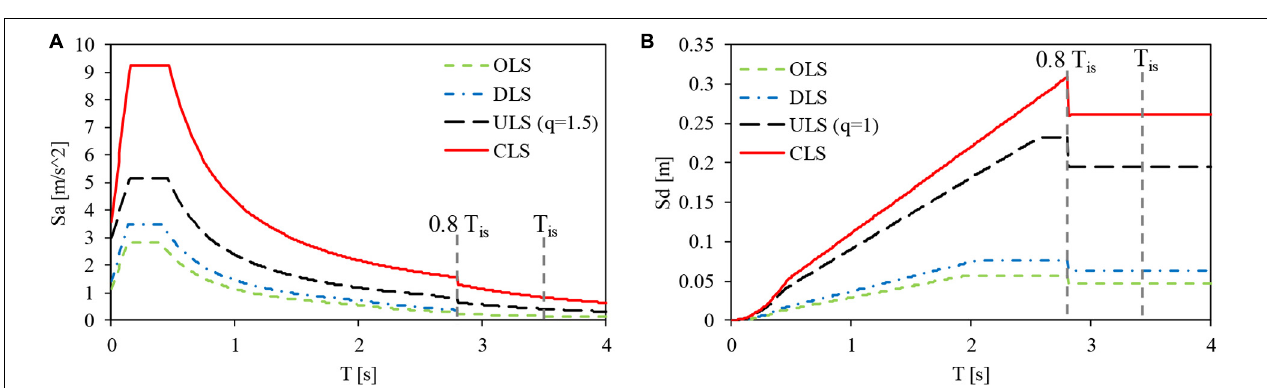
FIGURE 4 | Displacement (A) and pseudo-acceleration (B) spectra at the different limit